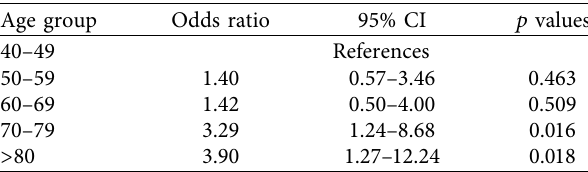
Table 4: Stratified age for confidence